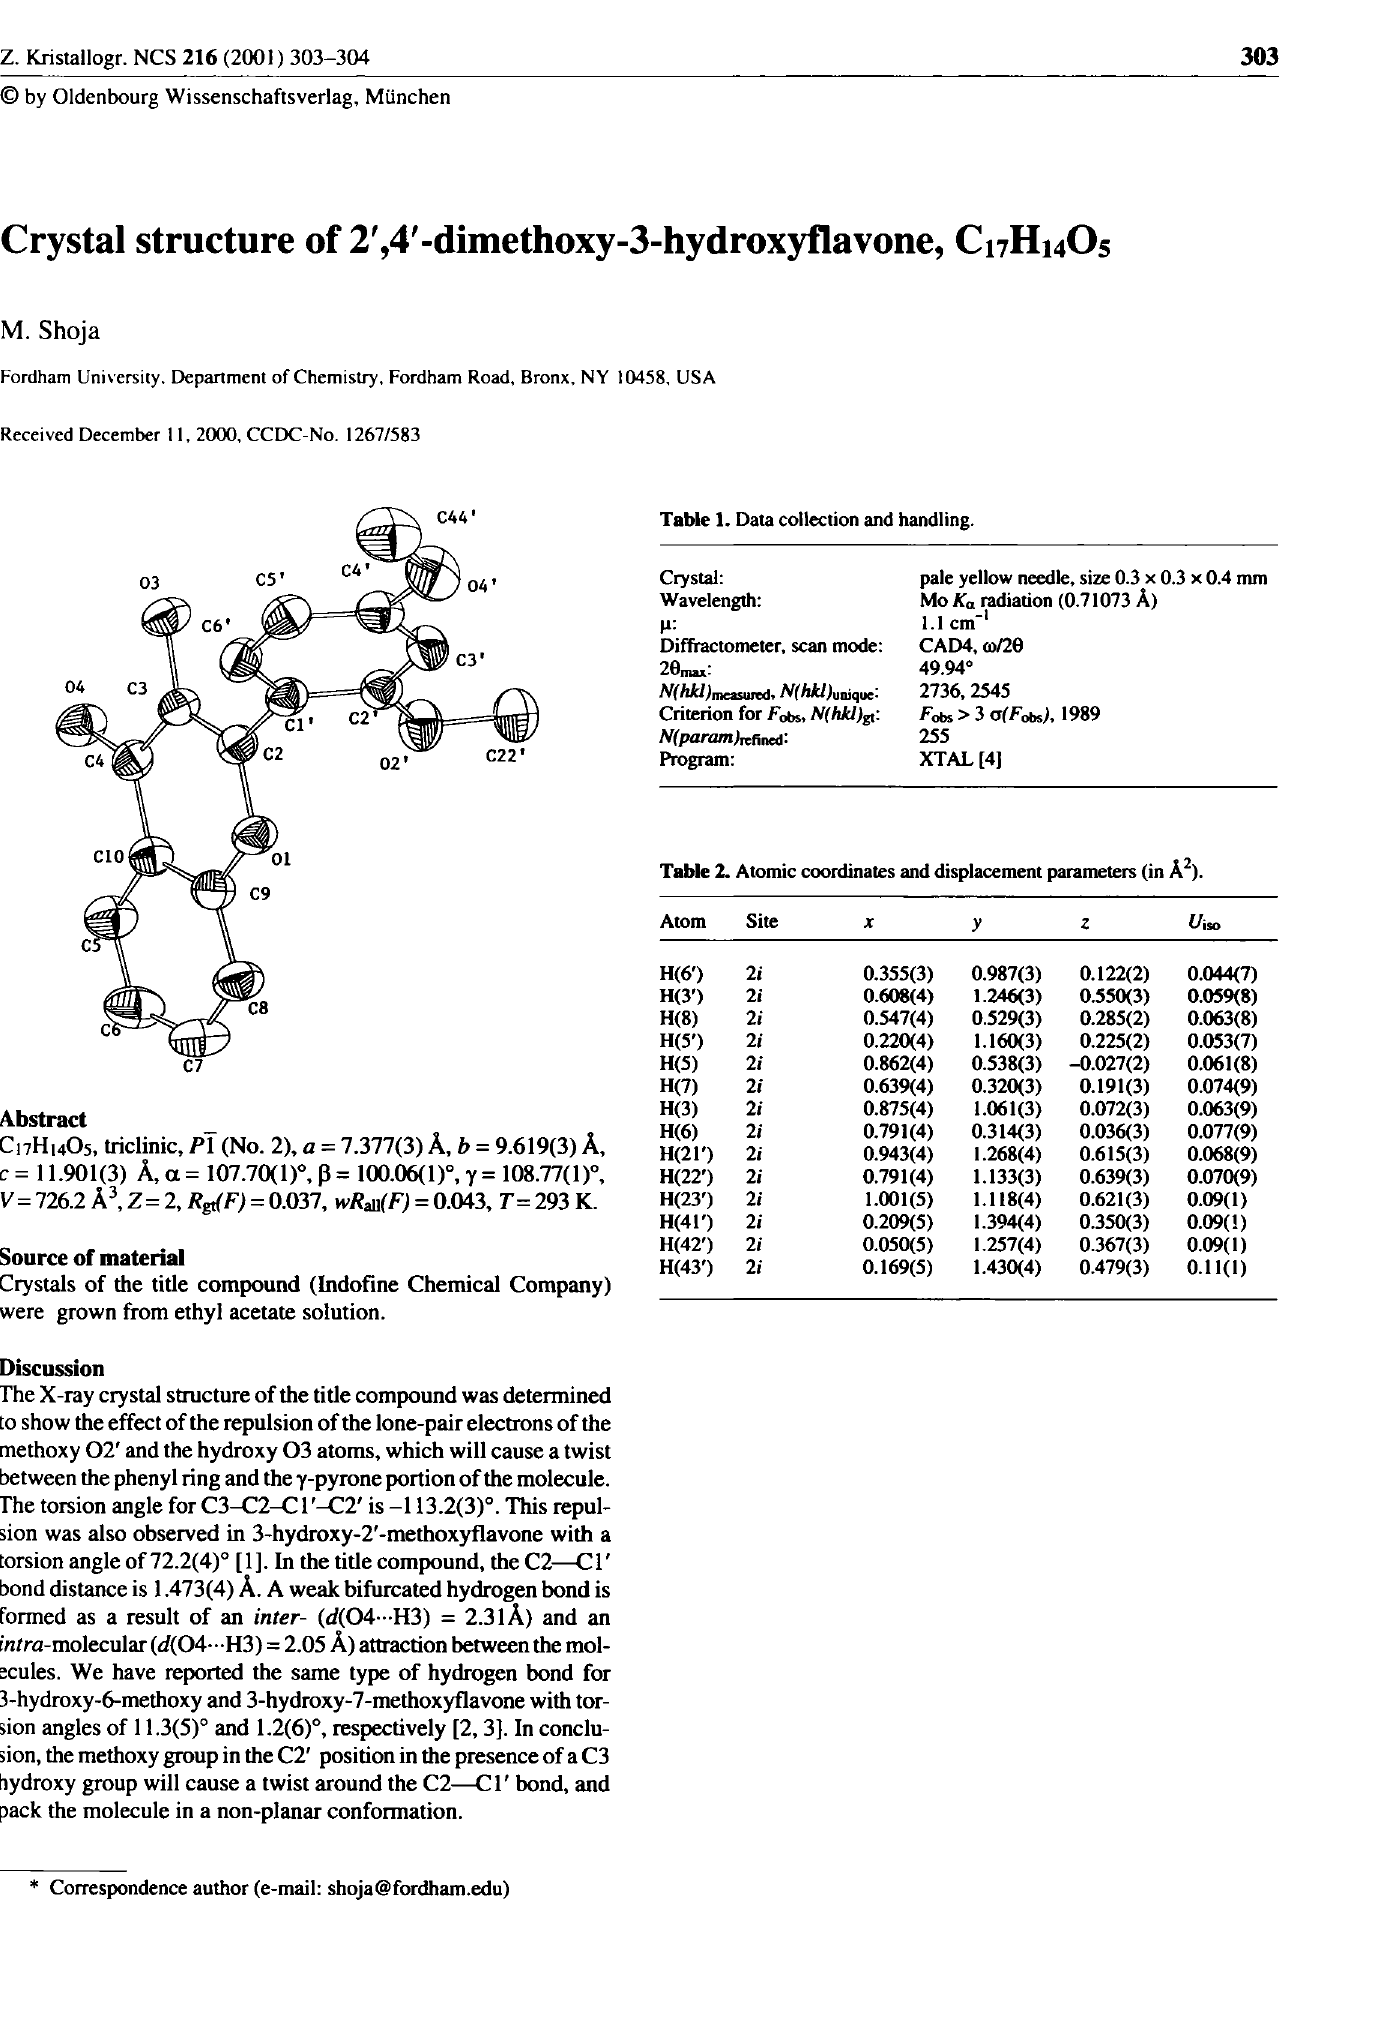
Table 1. Data collection and handling.